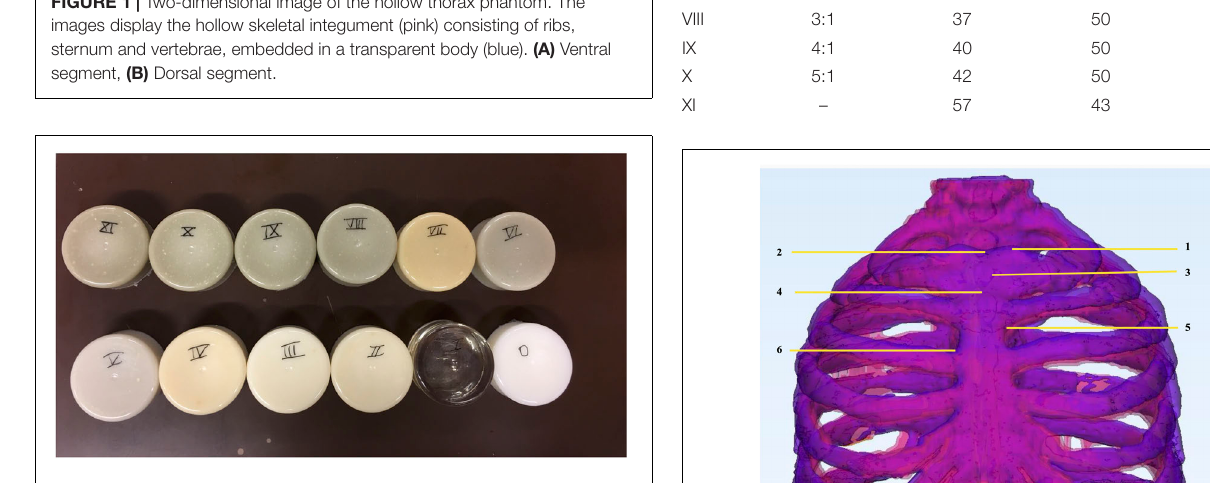
FIGURE 2 | Radiopaque amalgamate samples used for analyzing radiodensities. The image displays cured radiopaque amalgamate samples in 12 different compositions labeled from 0 to XI.